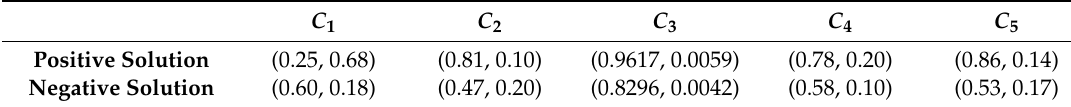
Table 10. Positive and negative solutions.